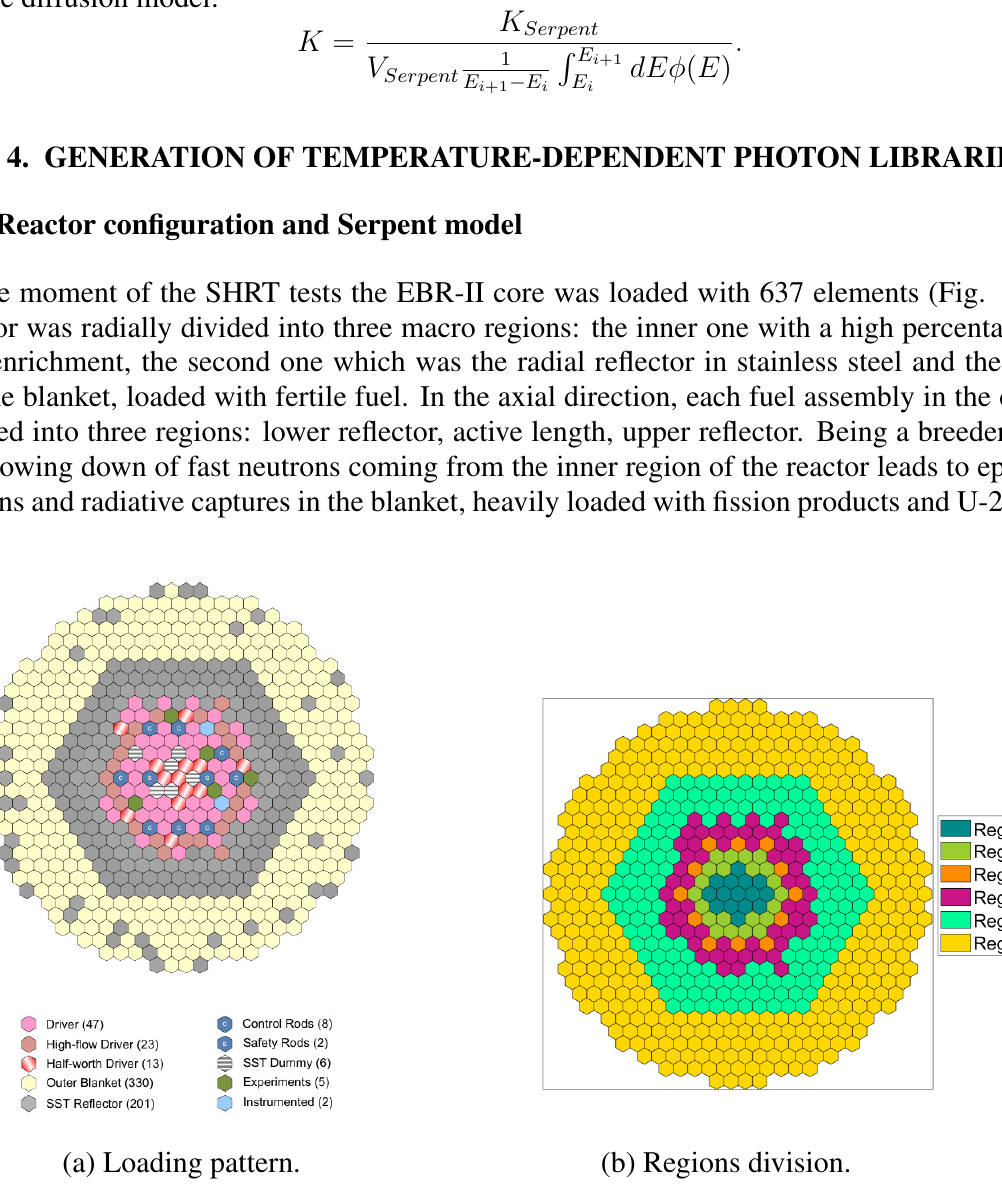
Figure 1: EBR-II core loading pattern for SHRT-45R and reference Serpent model. inner core region contained several sub-assembly types [10]: fuel driver (MARK-II AI, MARK- IIA), dummy elements (SST), control (HWC) and safety (S) rods, experimental driver (XY-16, X320C, X402A, X412, XETAGS) and instrumented ones (XX10, XX09). For the fuel